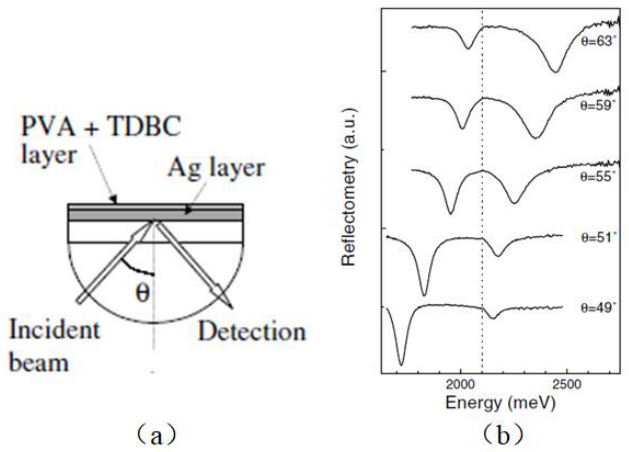
Figure 3. ( a ) Layout of reflectometry experiment showing the sample and the BK7 hemispherical prism. ( b ) Reflectometry spectra for various angles as a function of the incident light energy [56].